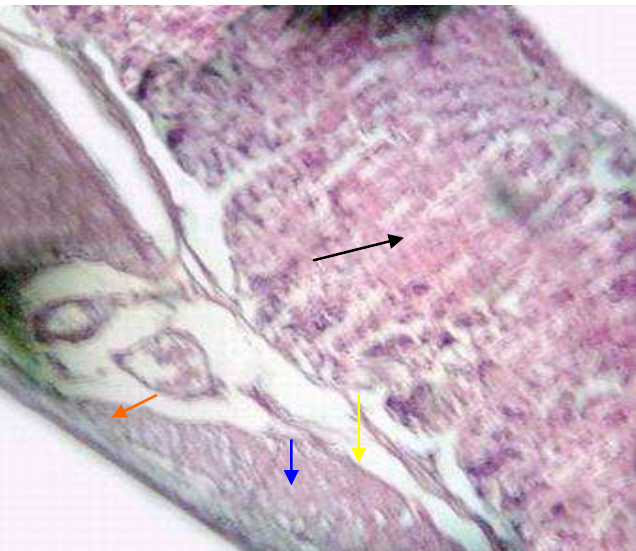
Figure (4): histological section of the intestine notice the hyperplasia and hypertrophy of the mucosa with infiltration of inflammatory cells in the sub mucosa also there is edema and congestion of the blood